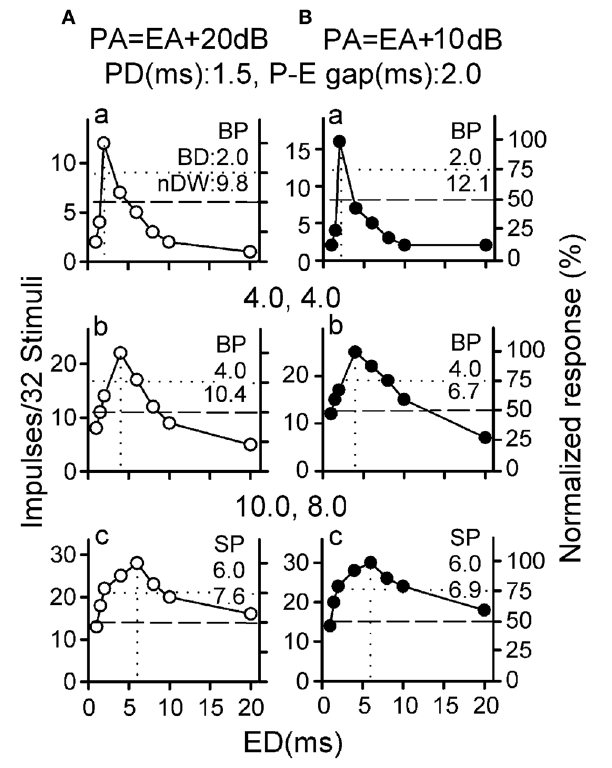
FIGURE 3 | (A,B) The echo duration tuning curves of a collicular neuron determined with three P-E pairs with varied pulse duration and P-E gap at 20-dB (unfilled) and 10-dB (filled) P-E amplitude differences [Adapted from Jen and Wu